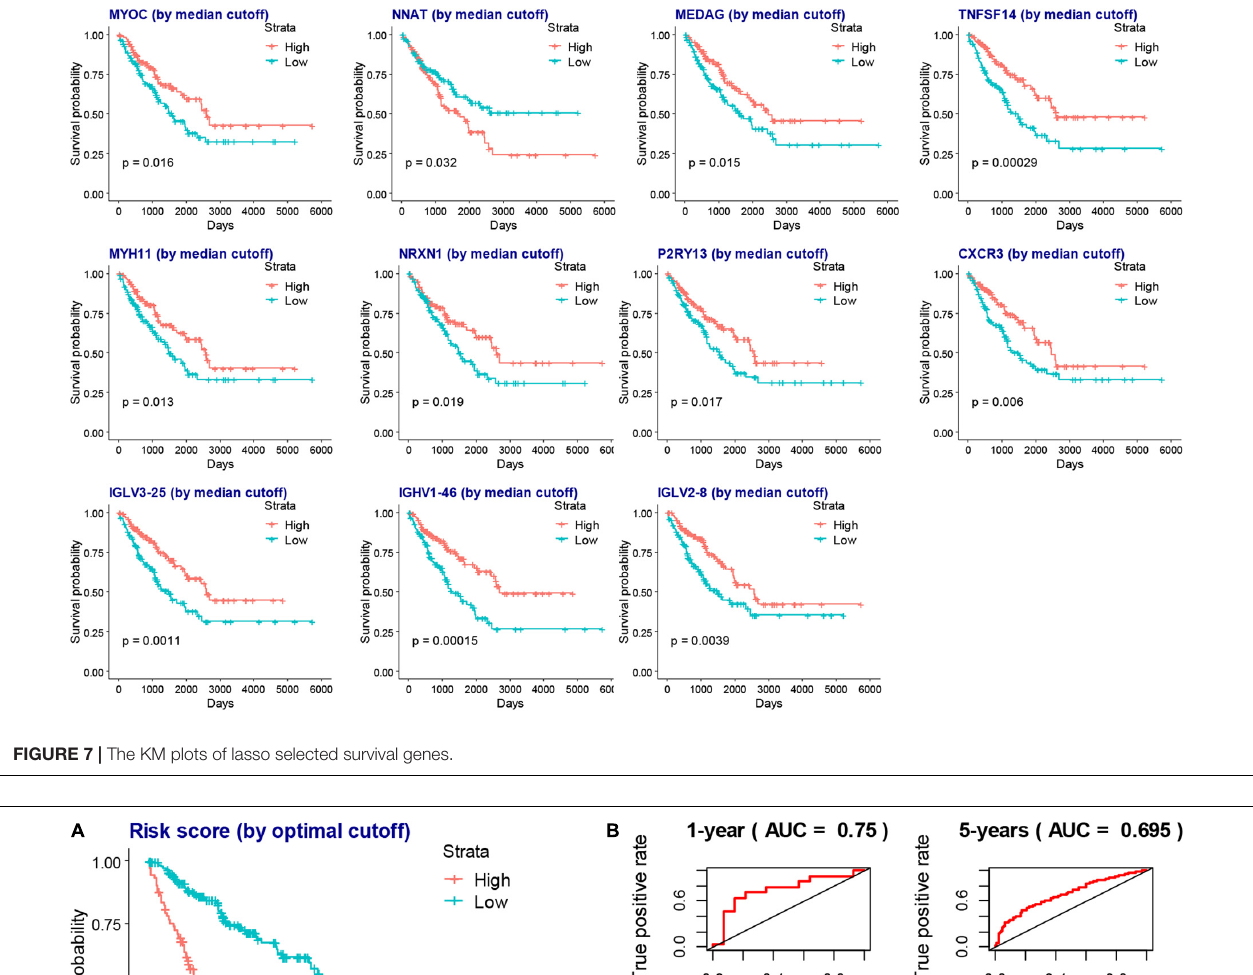
FIGURE 7 | The KM plots of lasso selected survival genes.